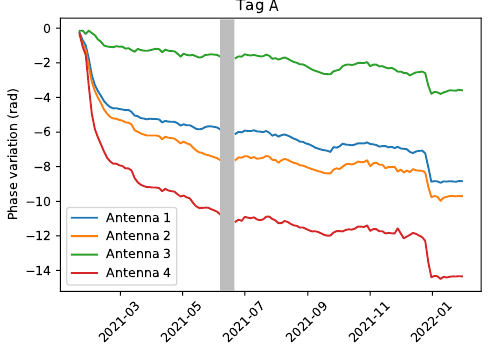
Figure 6. Unwrapped phase variation for tag A, measured by four antennas at a frequency f = 865 MHz, from January 2021 to February 2022. The grey bar shows a period of missing data due to hardware failure. Data was directly available after replacement of the malfunctioning device.